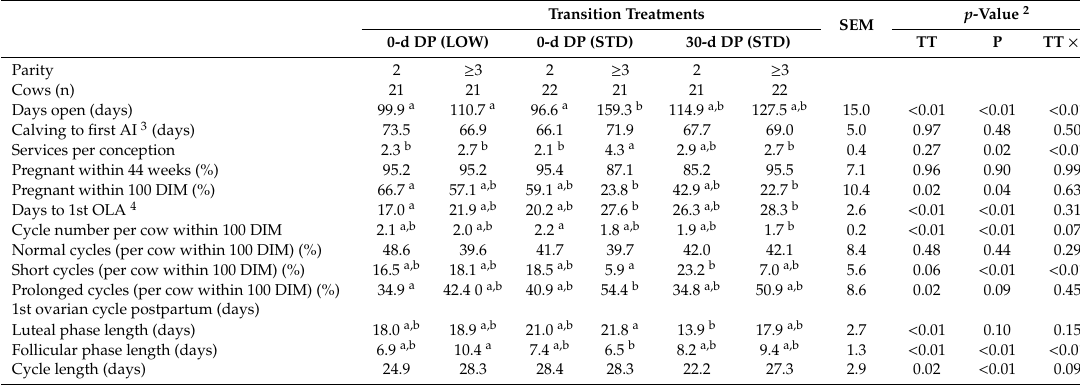
Table 2. Reproduction measures and incidence of normal and abnormal ovarian cyclicity within 100 days in milk (DIM) of cows with di ff erent transitiontreatments 1.